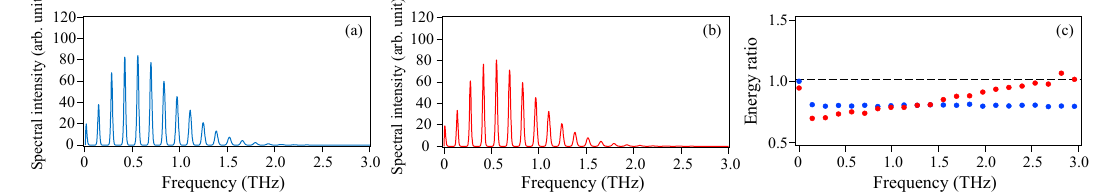
Figure 14. Spectral traces of the THz-TDS outputs averaged over 2000 single-shot spectra, when Langevin noise is ( a ) excluded and ( b ) included and m in Equation (10) is set to 2; ( c ) ratio of the energy at each line spectrum in ( a ) (blue circles) and ( b ) (red circles) to that in Figure 12a.